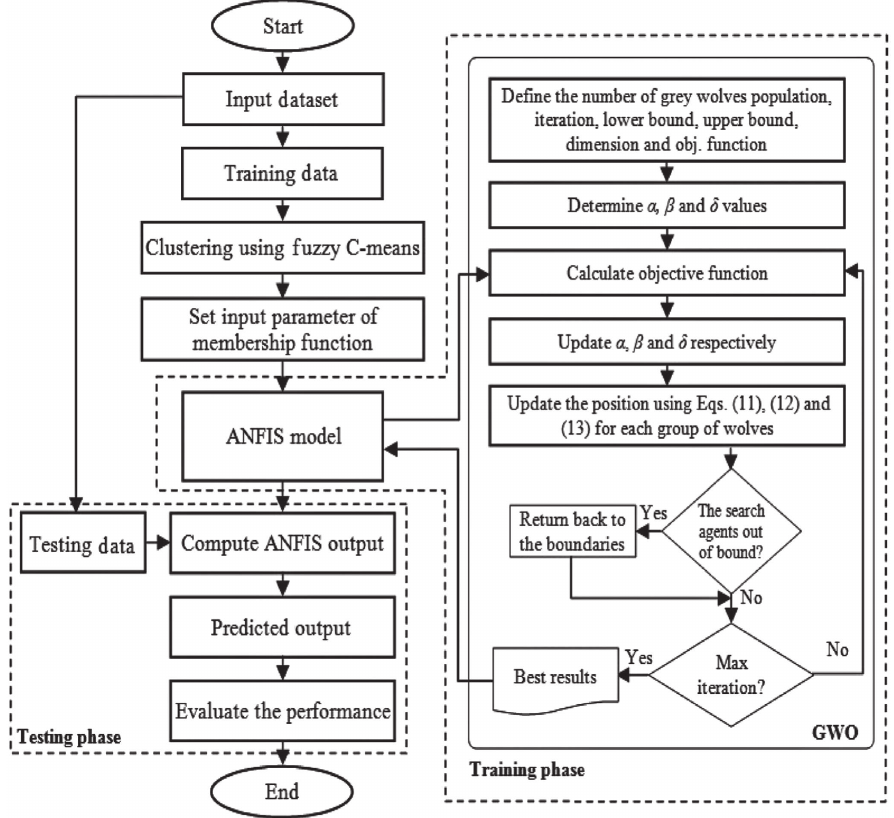
Figure 3: Proposed ANFIS-GWO